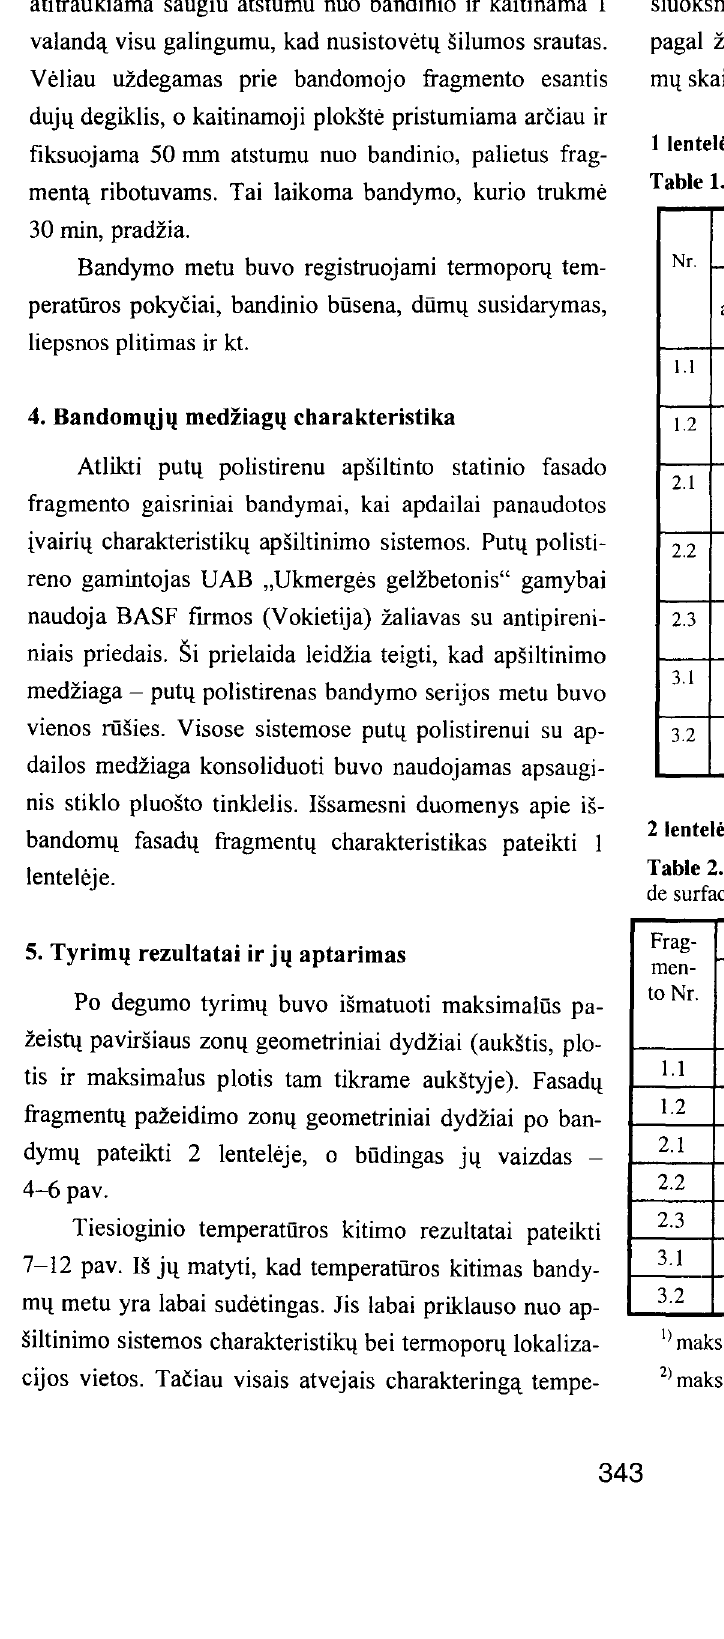
Table 1. Characteristics of the tested facade fragments Bandinio matmenys Polistireno cha- Apdailos rakteristikos tinkas Nr. pavirsiaus, plotas, marke,